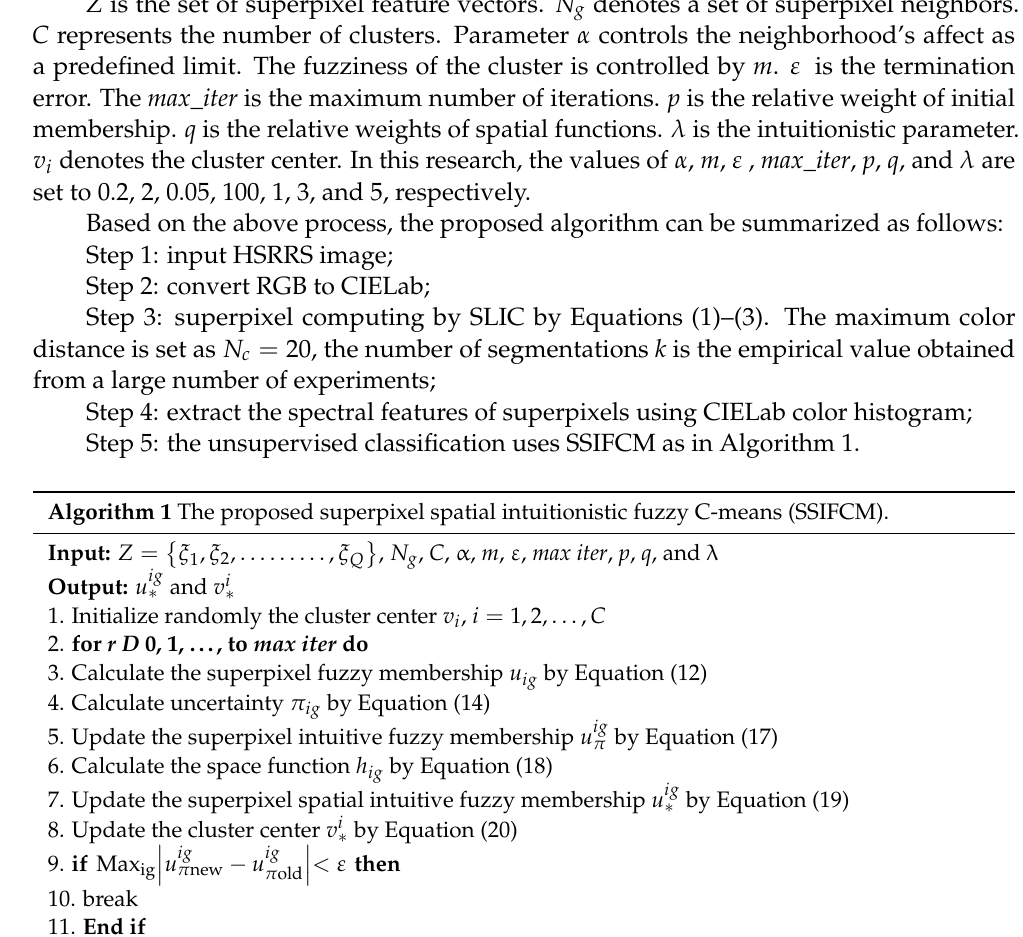
Algorithm 1 The proposed superpixel spatial intuitionistic fuzzy C-means (SSIFCM).